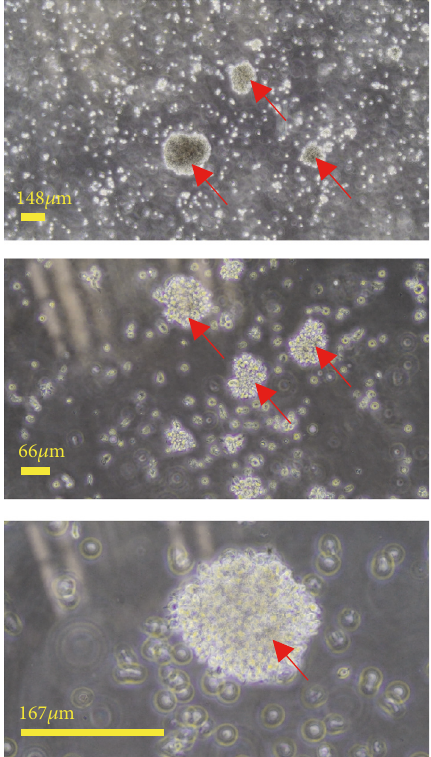
Figure 1: Microscopic examination of PBMC-derived EBV- immortalized B-cells from a RA patient 8A one week after infection. TheseimmortalizedcellsareannotatedasLCL-8A.Redarrowsshow the rosette-like EBV-immortalized LCLs at 4x (upper panel), 10x (middle panel), and 20x (bottom panel) magnifications. Scale bars are indicated in